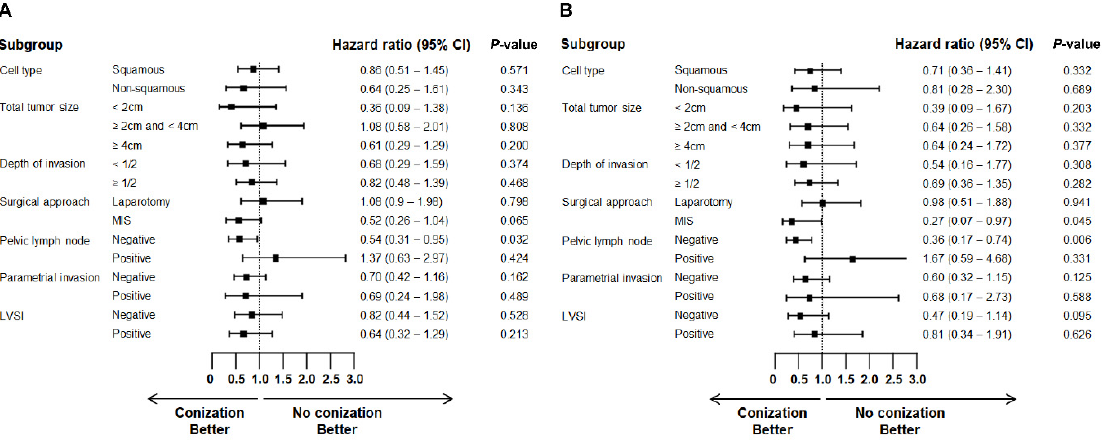
Figure 2. Forest plot of hazard ratio for ( A ) recurrence and ( B ) death in subgroup analysis. Additional survival analysis was performed by selecting subgroups of three varia ‐ bles: surgical approach, lymph node metastasis, and tumor size. Kaplan–Meier curves demonstrating PFS and OS of conization in each subgroup are shown in Figures 3 and 4, respectively. Among patients who underwent MIS radical hysterectomy, the conization group showed better PFS (5 ‐ year PFS, 91.2% vs. 82.7%, p = 0.021) and OS (5 ‐ year OS 96.9% vs. 93.2%, p = 0.066) than the control group (Figures 3A and 4A). In contrast, there was no difference in PFS (5 ‐ year PFS, 86.7% vs. 88.9%, p = 0.769) or OS (5 ‐ year OS, 95.0% vs. 92.9%, p = 0.154) for conization in patients who underwent open radical hysterectomy (Figures 3B and 4B). Among patients with negative pelvic lymph nodes, the preoperative